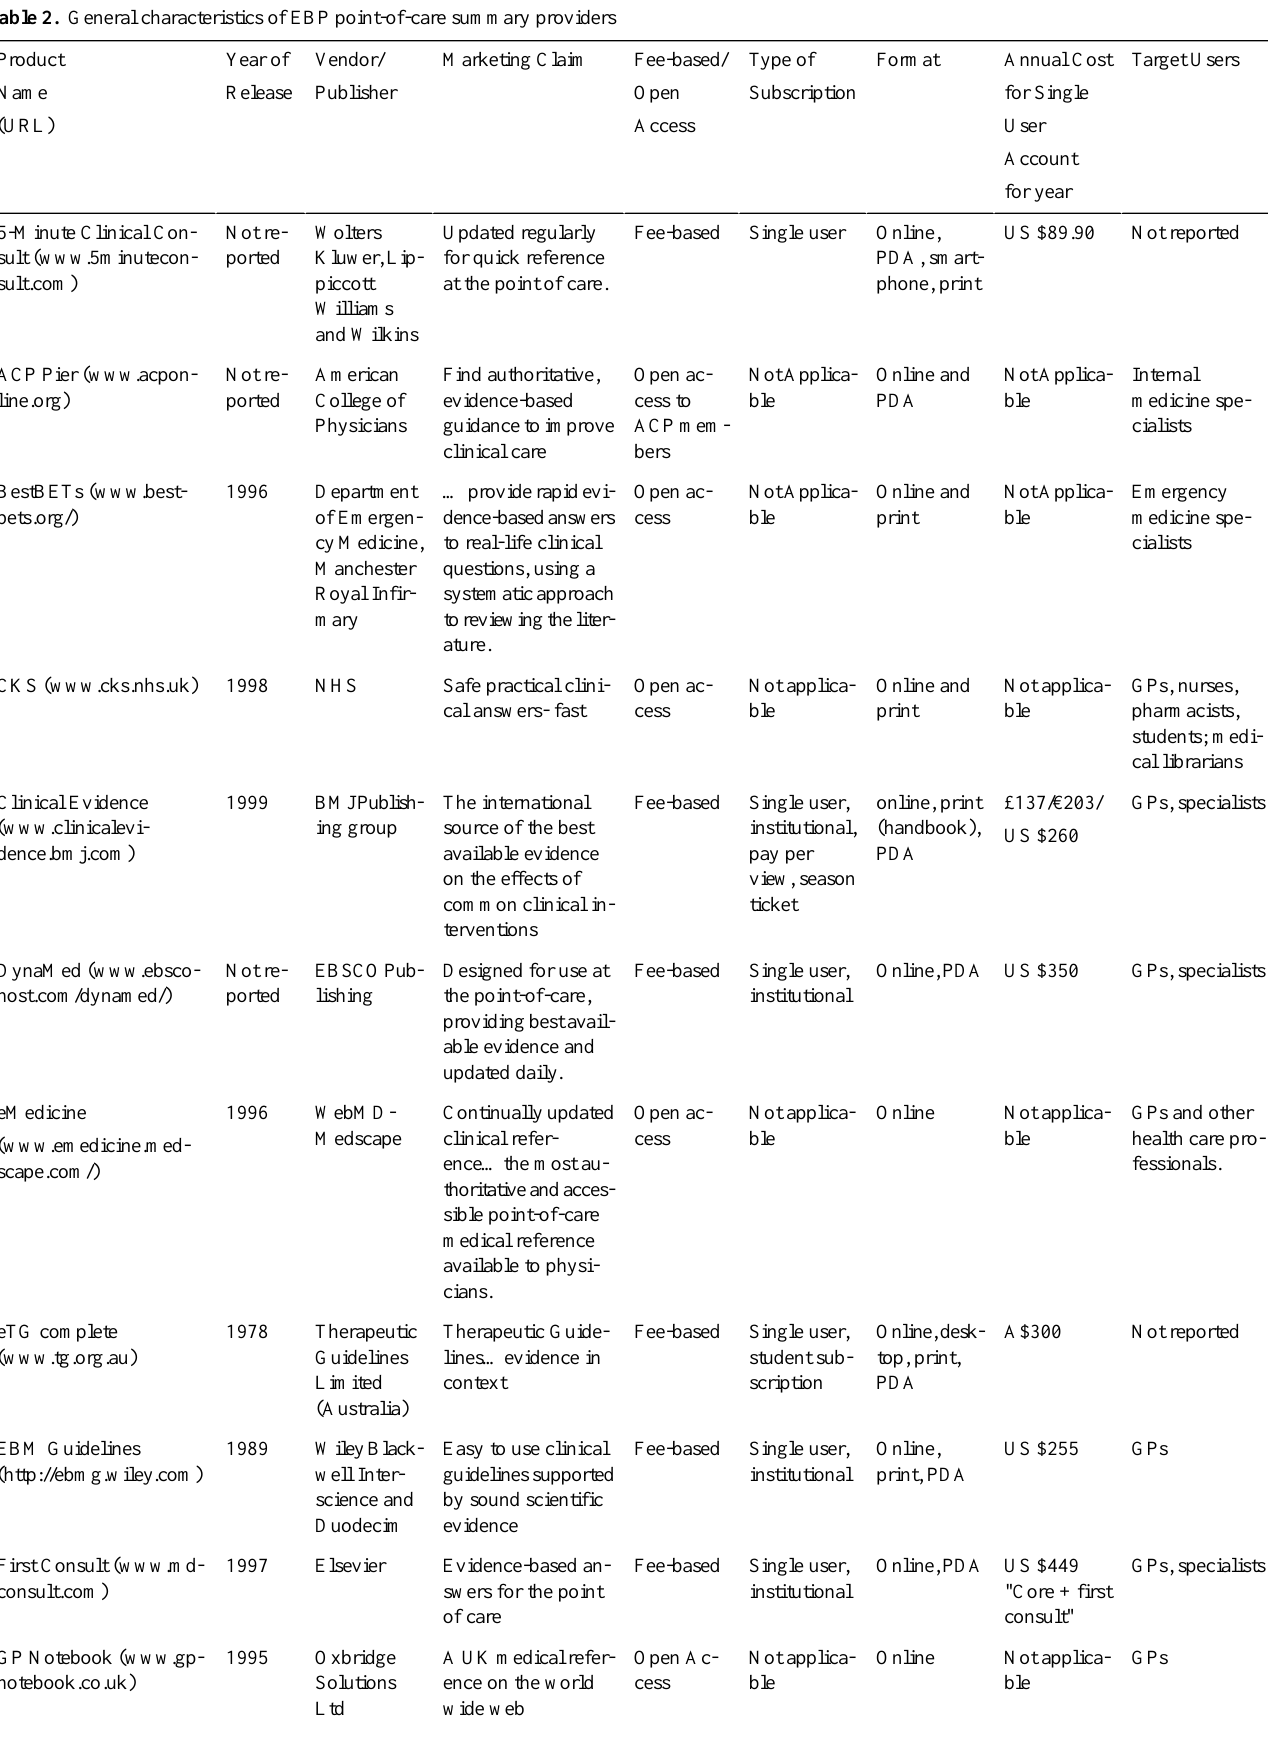
Table 2. General characteristics of EBP point-of-care summary